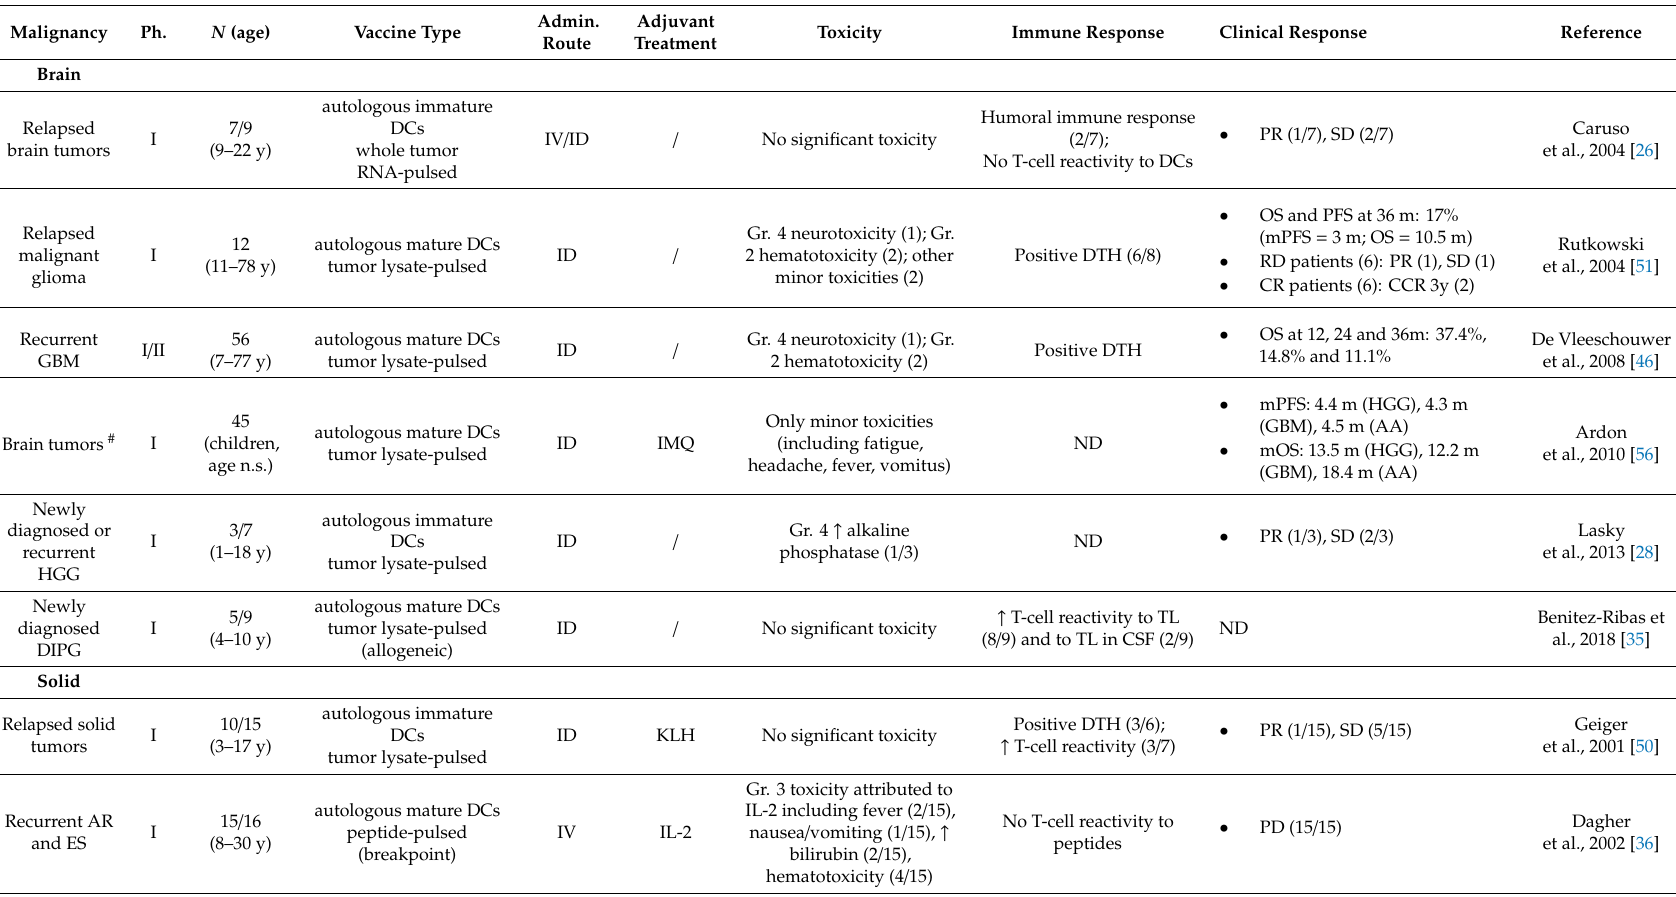
Table 1. Published dendritic cell (DC)-based vaccination studies involving pediatric cancer